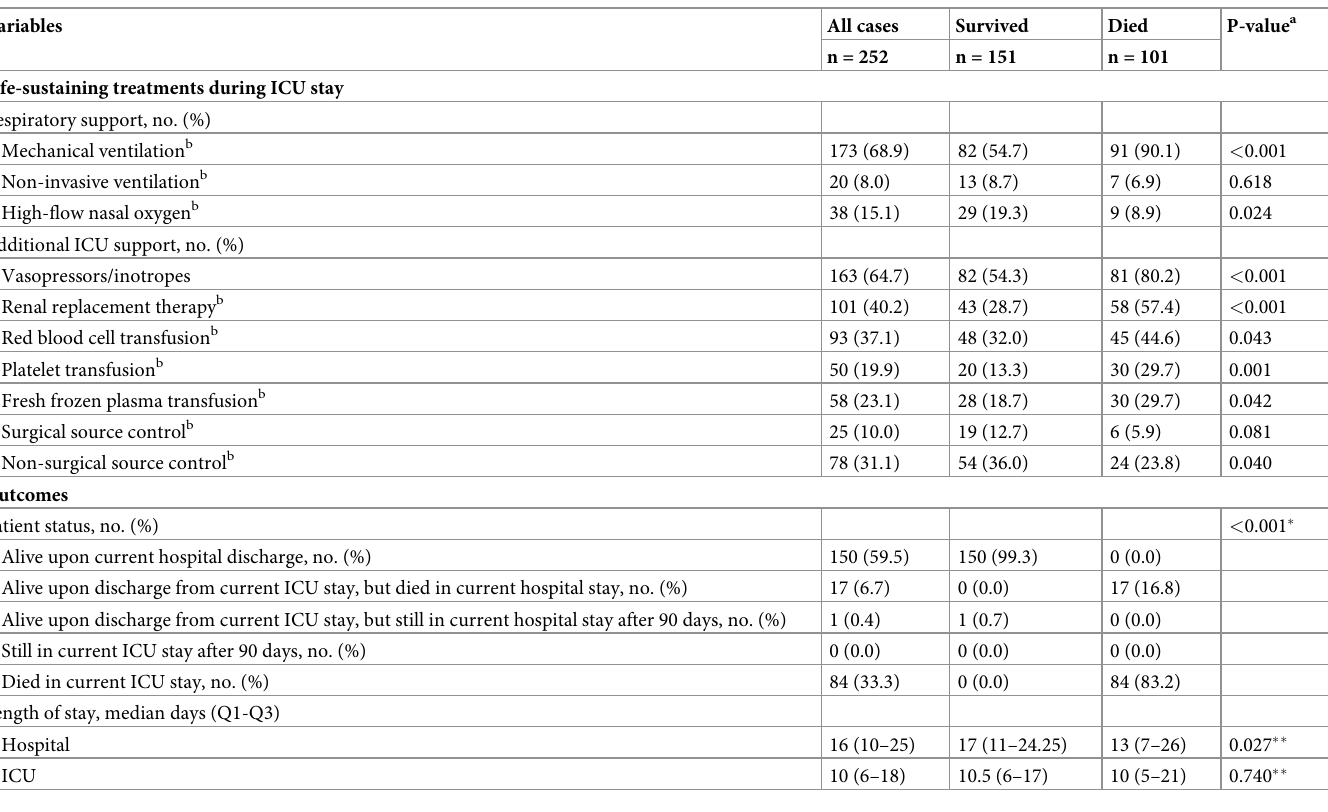
Table 2. Life-sustaining treatments during intensive care unit (ICU) stay and outcomes of ICU patients with sepsis according to hospital survivability.